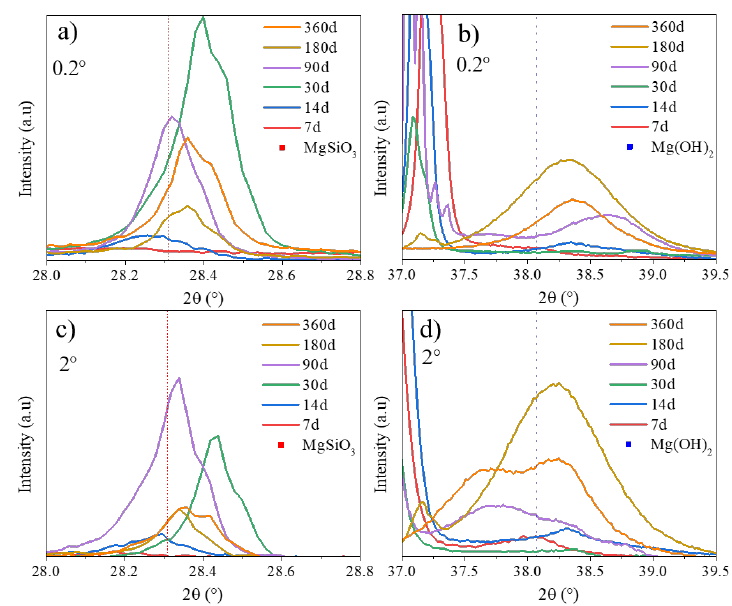
Figure 8. Zoom of XRD patterns of the zone between 28° and 28.8° corresponding to the peak of MgSiO 3 at ( a ) 0.2°-PS and ( c ) 2°-PS and a second zone between 37° and 39.5° corresponding to the peak of brucite at ( b ) 0.2°-PS and ( d ) 2°-PS.